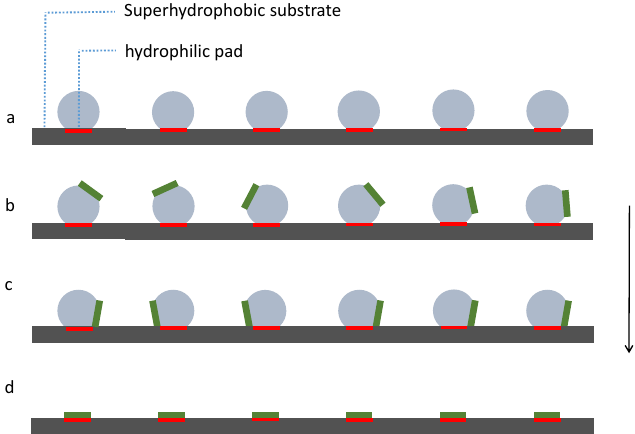
Figure 4. Capillary self-alignment strategy on a softsubstrate: ( a ) Droplets are deposited on patterned hydrophilic/superhydrophobic PDMS surface; ( b ) chips are randomly placed on the droplets; ( c ) droplets are evaporating and chips are tilted; ( d ) droplets are evaporated and chips (in green) are aligned with the pads (in red).